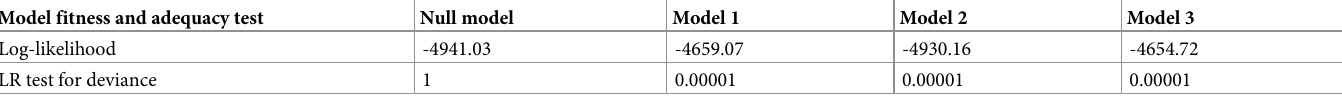
Table 5. Model fitness and adequacy test statistics for all level predictors of under-five mortality in rural Ethiopia. Model fitness and adequacy